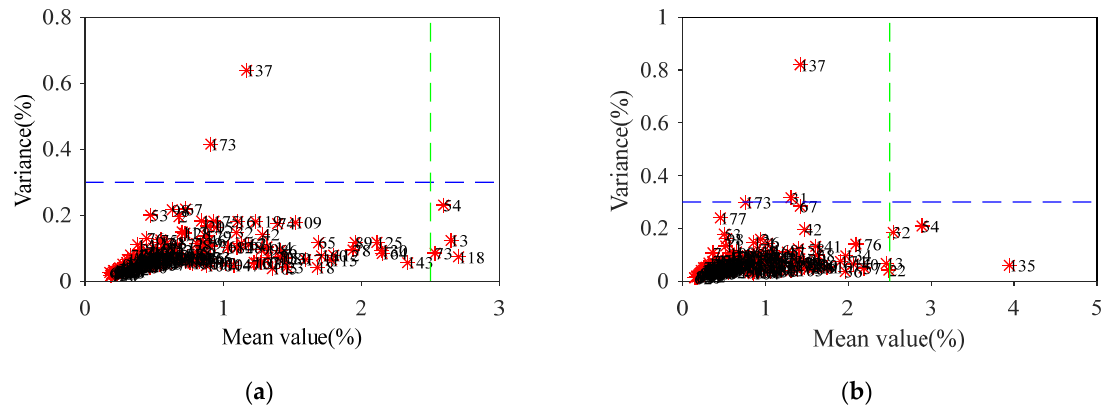
Figure 2. The predicted residual mean and variance distribution map for cellulose ( a ) and hemi- cellulose ( b ).